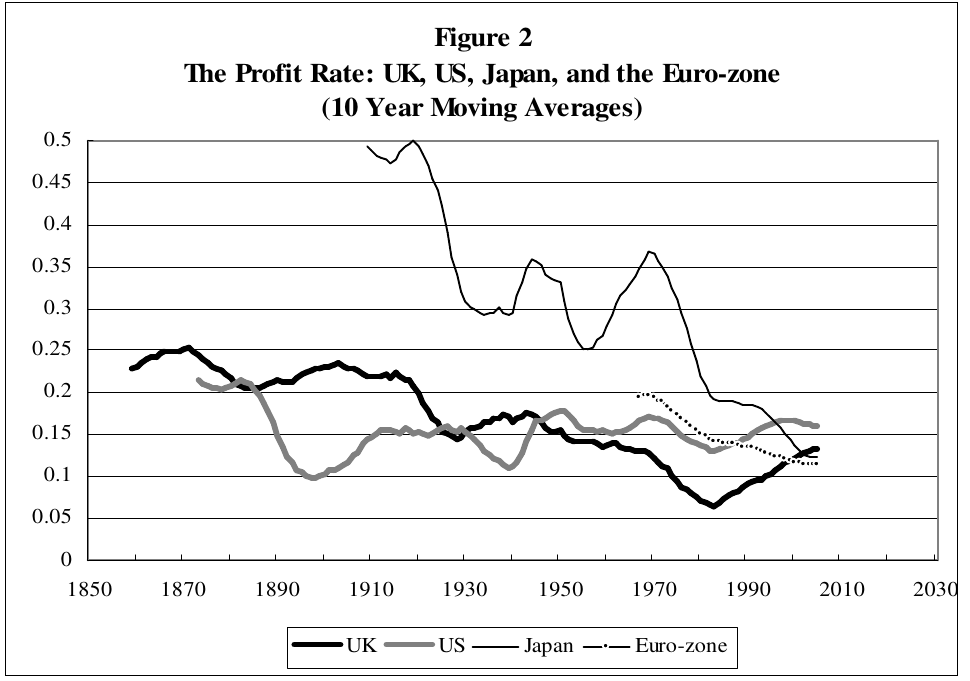
Figure 2 The Profit Rate: UK, US, Japan, and the Euro-zone (10 Year Moving